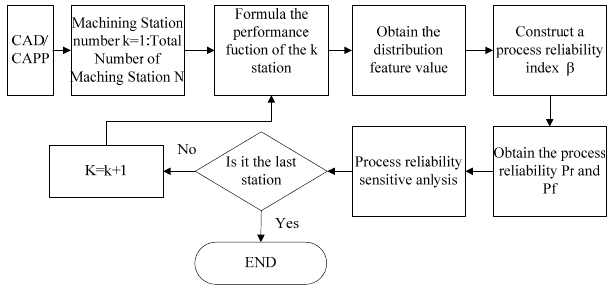
Table 1. Process reliability sensitivity